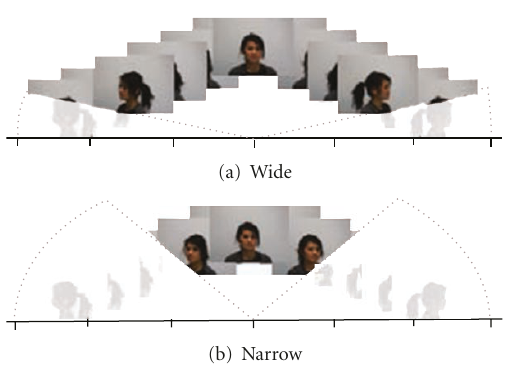
Figure 9: Angular range.